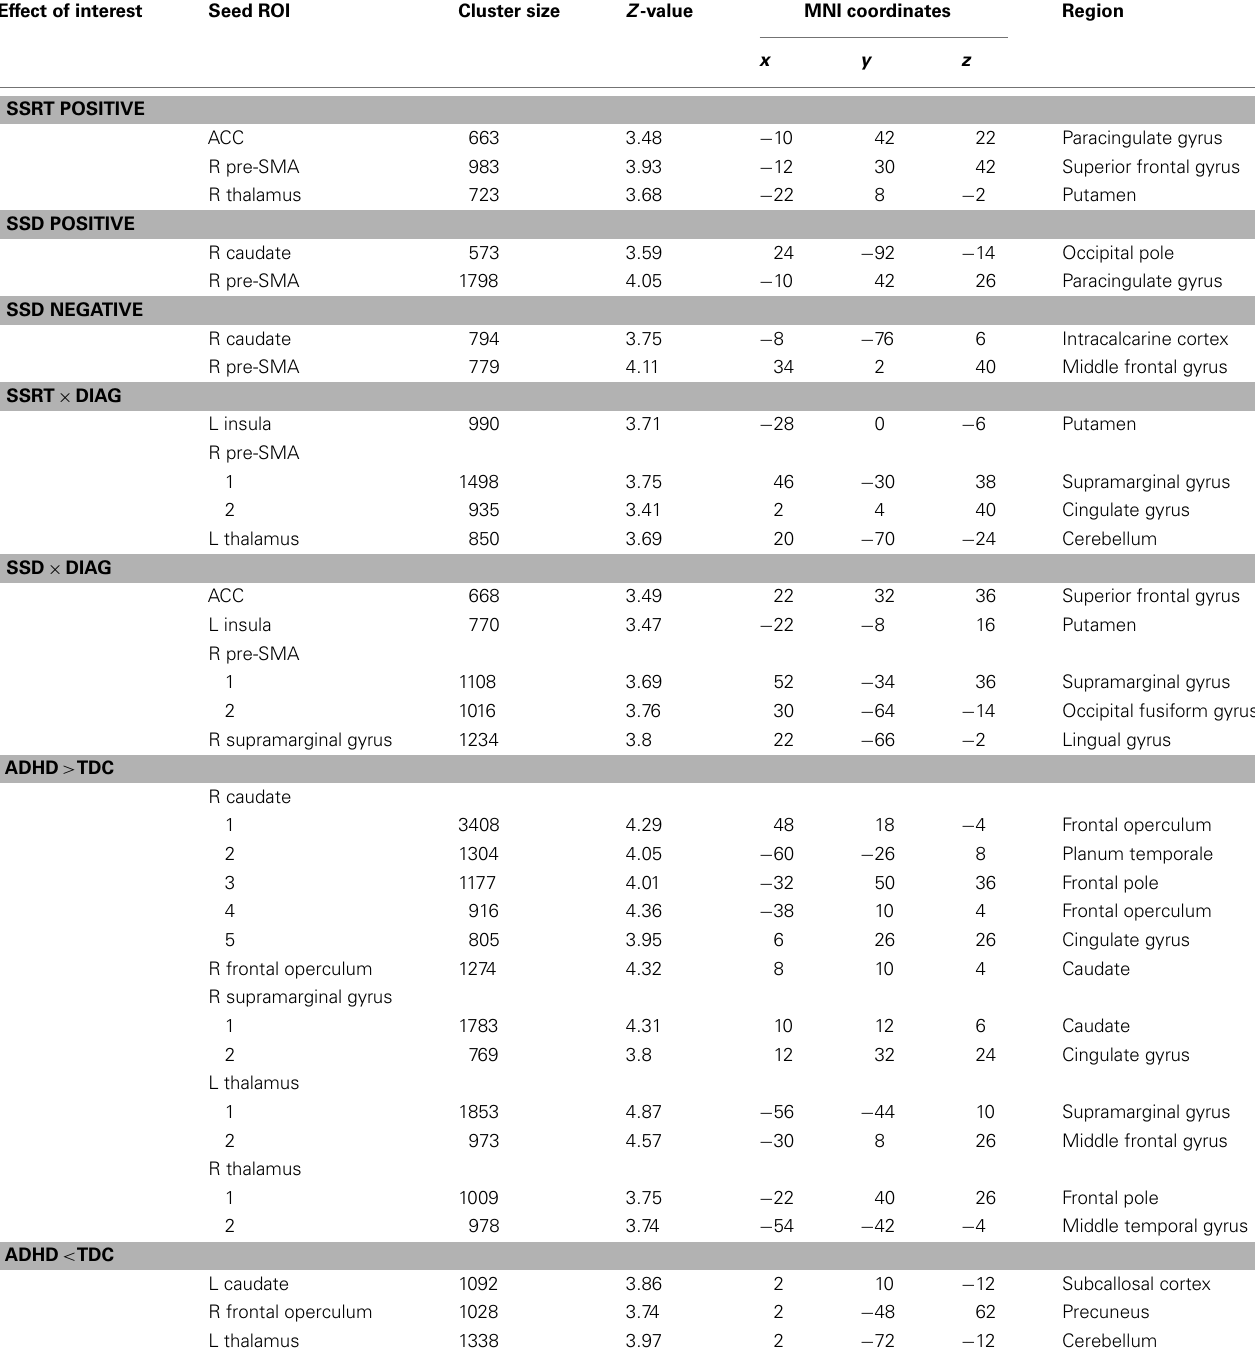
Table 4 | MNI152 coordinates and Harvard–OxfordAtlas regions associated with all effects of interest. Effect of